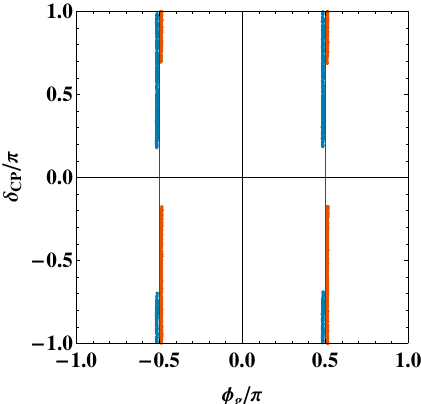
Figure 3 . The allowed regions of (cid:14) CP and (cid:30) g . At the orange (blue) points the sign of Y B is positive